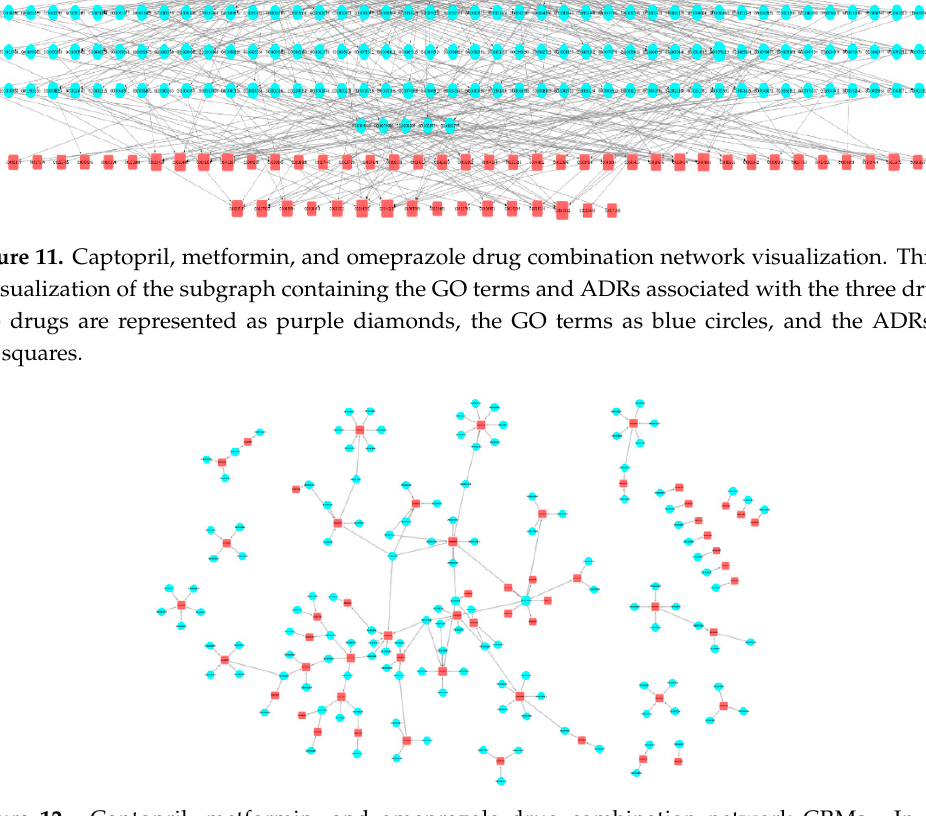
Figure 12. Captopril, metformin, and omeprazole drug combination network CRMs. In this visualization, red squares represent cADRs, and blue circles represent GO terms.